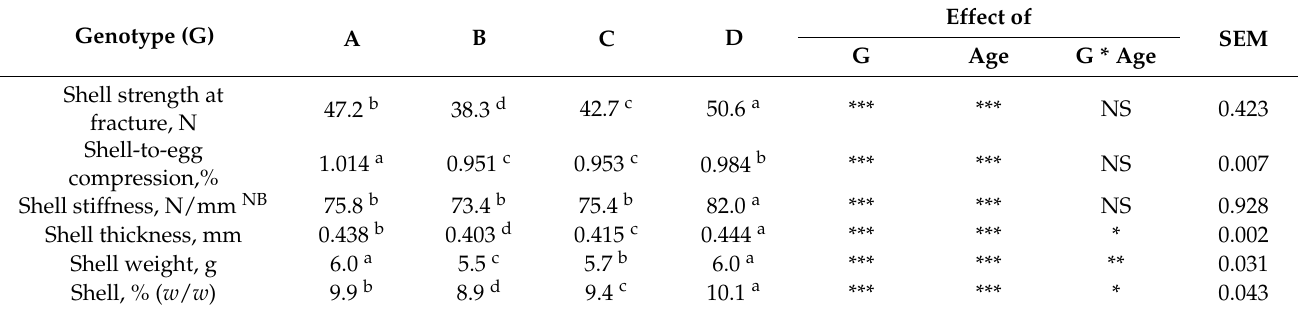
Table 2. Effect of hen genotype, A, B, C, and D, age, and their interaction on LS-means of egg shell parameters between the 21st and 54th week of age, n = 180 for genotype A and 270 for genotypes B, C and D. Genotype